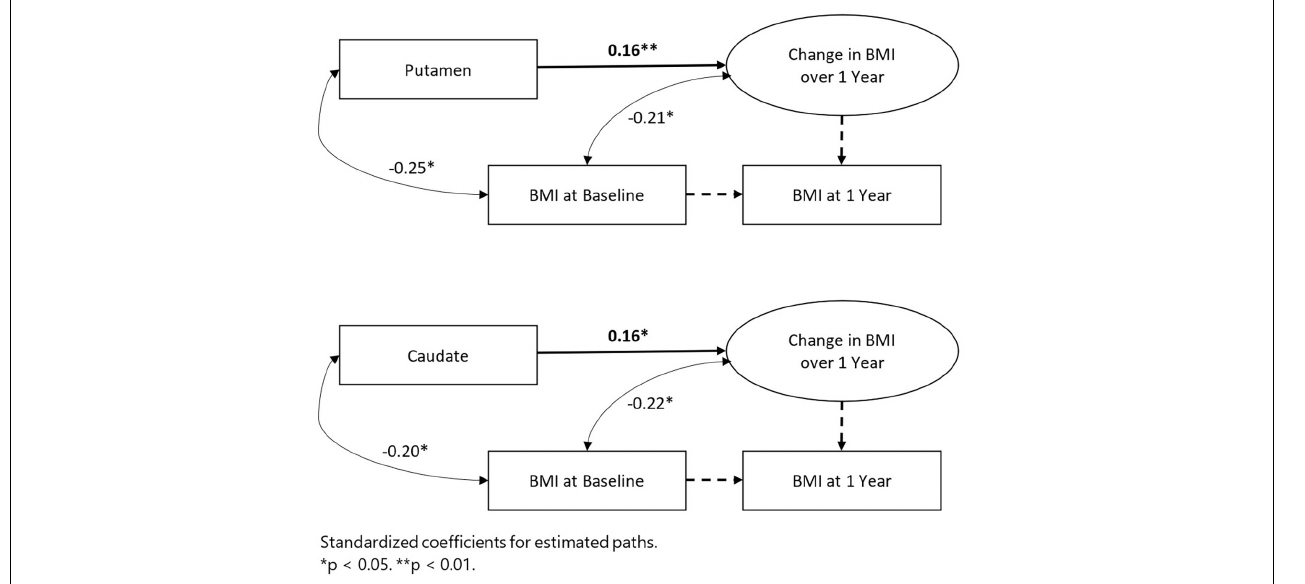
FIGURE 1 | Latent change score models linking BOLD signals to change in Body Mass Index (BMI). N = 363.